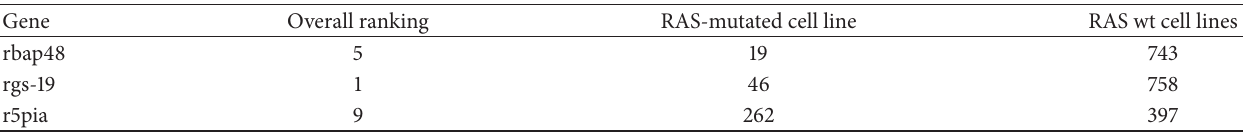
Table 2: Ranking of previously validated radiosensitivity genes when considering all cell lines ( 𝑛 = 35 ), RAS-mutated cell lines only ( 𝑛 = 14 ), and RAS wt cell lines only ( 𝑛 = 21 ). Significant differences in ranking occur when considering the biological variable of RAS mutation status. Gene Overall ranking RAS-mutated cell line RAS wt cell lines